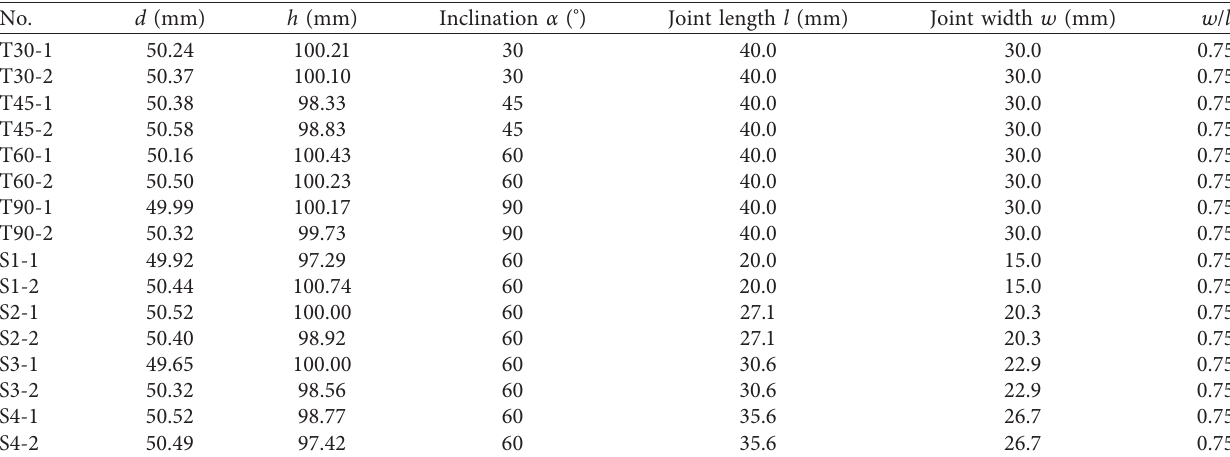
Figure 4: (a) Schematic diagram and (b) actual image of rough joint setting inside specimens, (c) specimens casting, and (d) finished Table 2: Size and basic setup of specimens and closed rough joint.